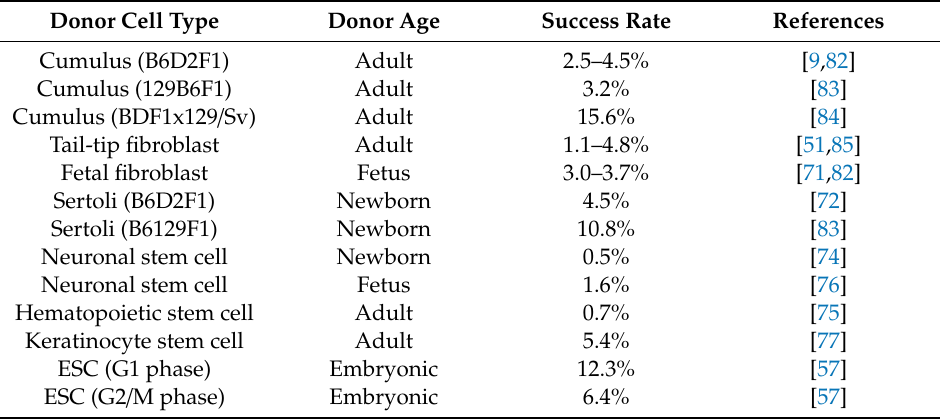
Table 1. The success rate of full-term development of mice cloned from di ff erent donor cells. Donor Cell